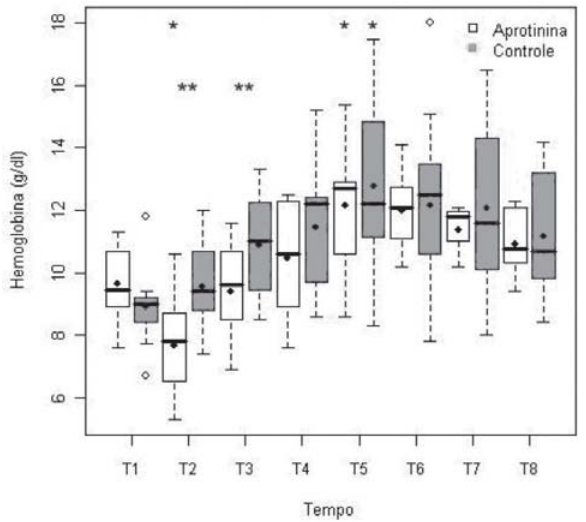
Fig. 1 - Taxas de hemoglobina (g/dl) nos grupos Aprotinina e Controle, nos tempos T1 a T8. As diferenças estatisticamente significativas estão